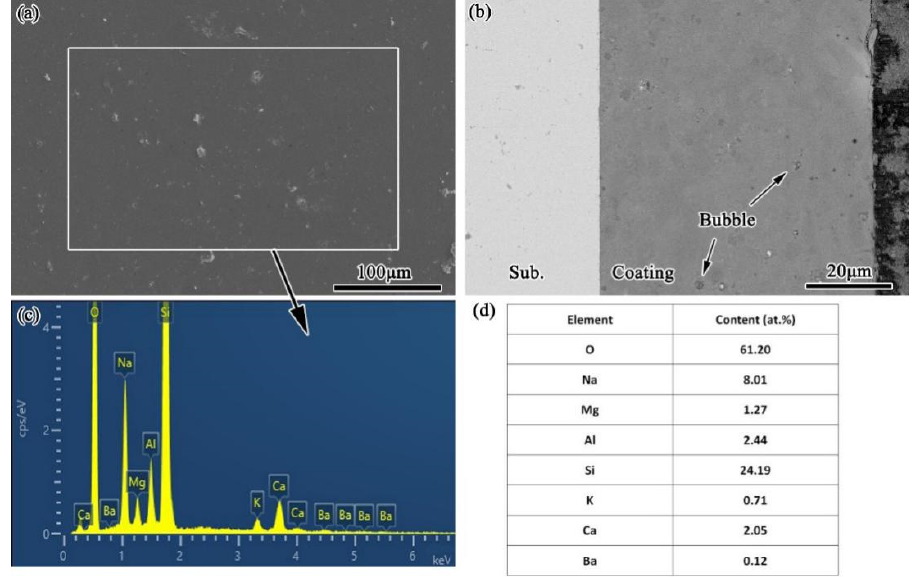
Figure 1. Surface image ( a ), cross-sectional image ( b ), and elemental profile (analyzed by EDS) ( c ) and ( d ) of the as-prepared GCC on MSS.